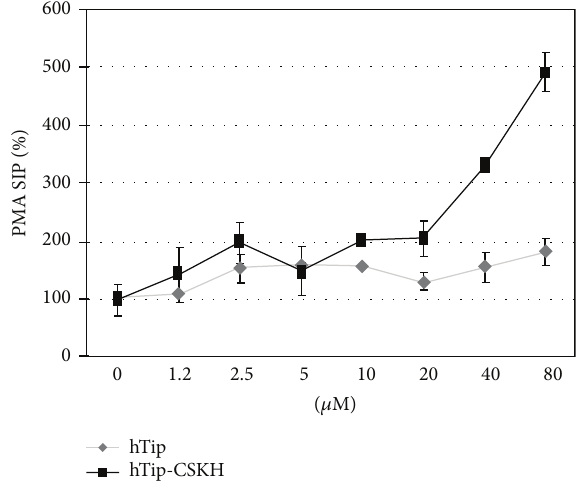
Figure3:hTip-CSKHinducedsimilar5-foldincreasedproliferation in PMA-stimulated PBMC. Human PBMC exposed to different hTip-CSKH or hTip concentrations for 1h were stimulated with 25 ng/mL PMA. Cells were assessed for [ 3H ] -thymidine incorpora- tion after 72 h. Stimulation index percentage (SIP) is